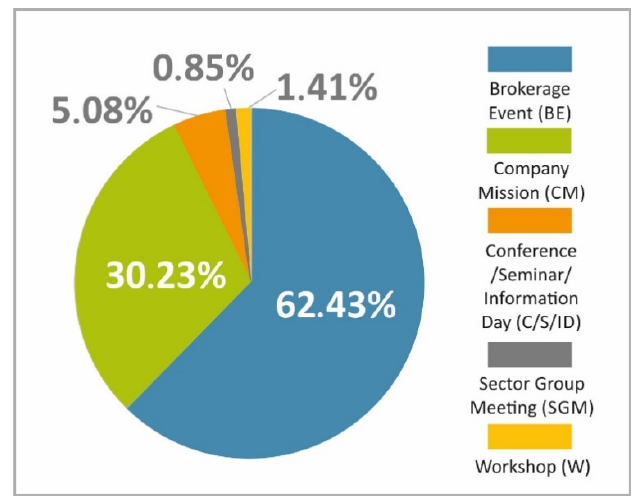
Figure 1. Structure types of events in the Enterprise Europe Network (EEN) in 2017–2018 for entire Europe.